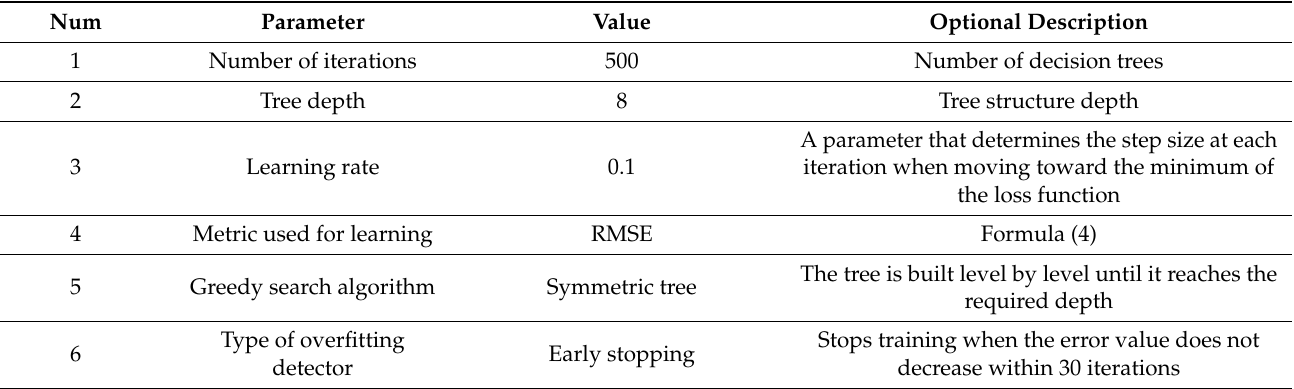
Table 6. Model parameters based on CatBoost.